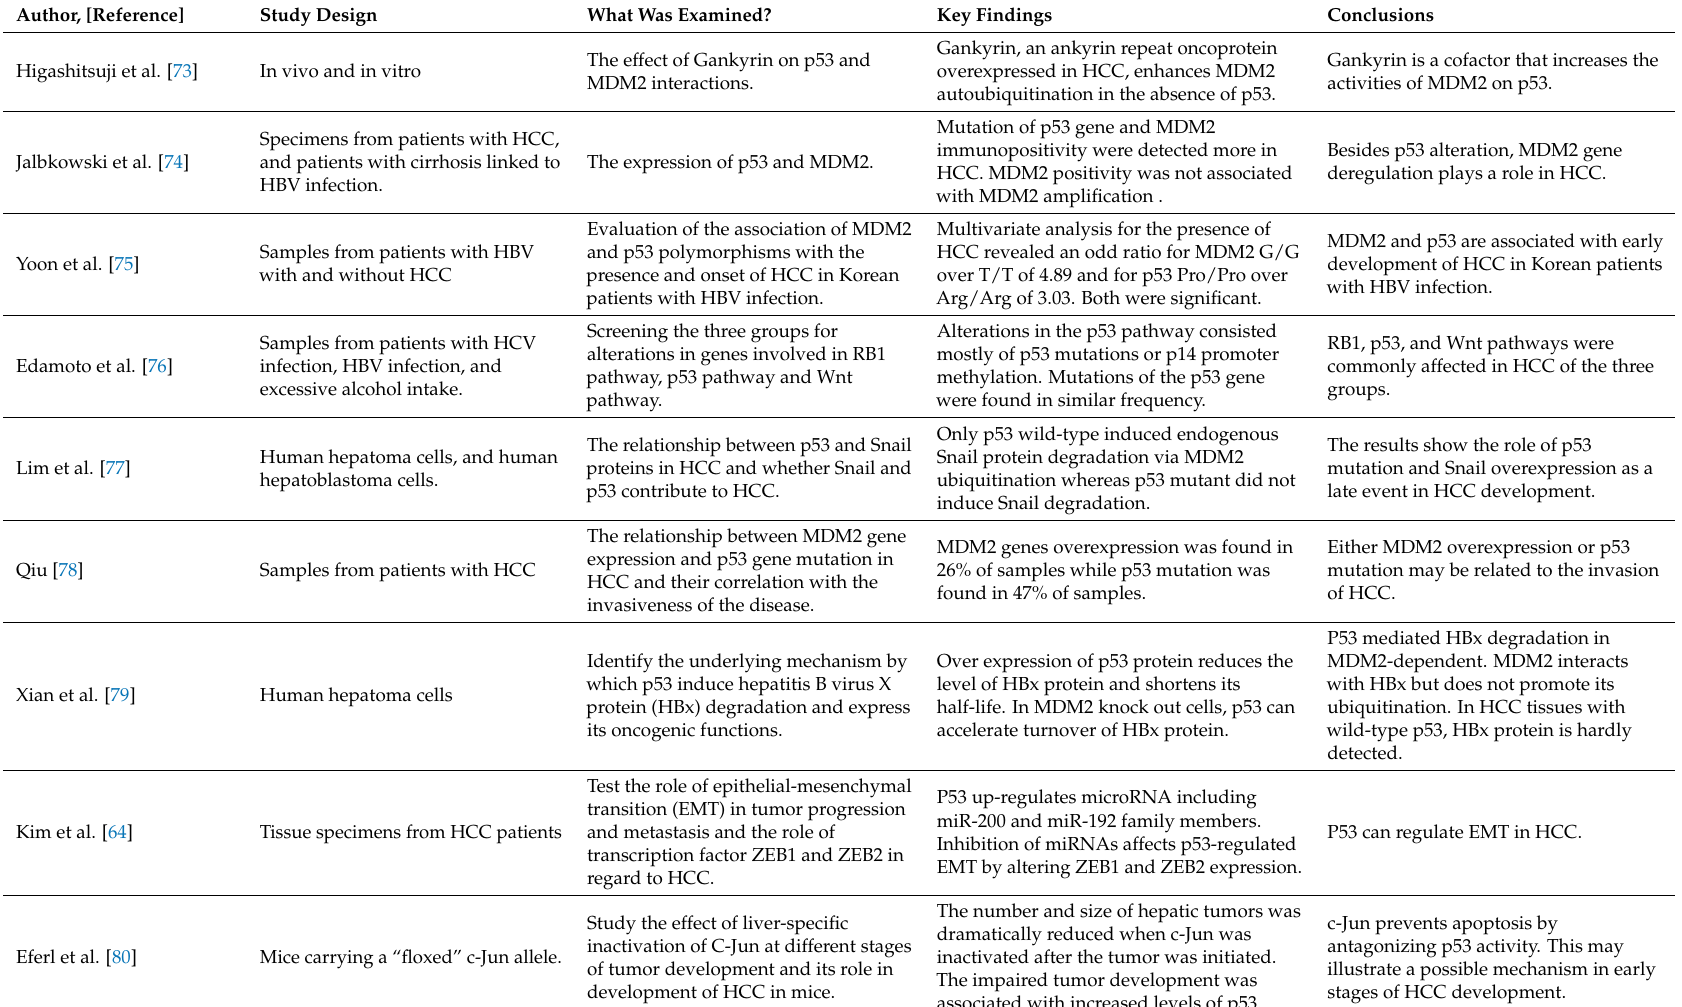
Table 2. Role of p53 and murine double minute 2 (MDM2) pathways in hepatocellular carcinoma